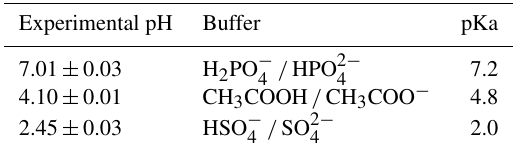
Table 2. Buffer systems used for hydrolysis studies and their corre- sponding